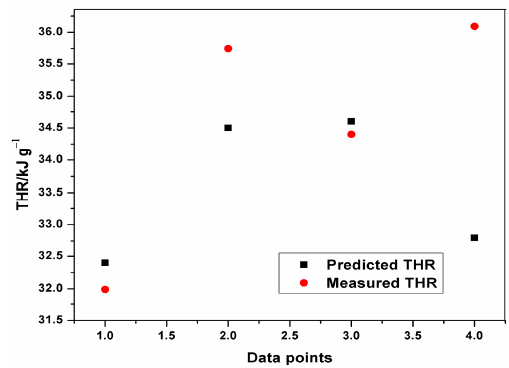
Figure 11. Plot of predicted and measured THR for testing.